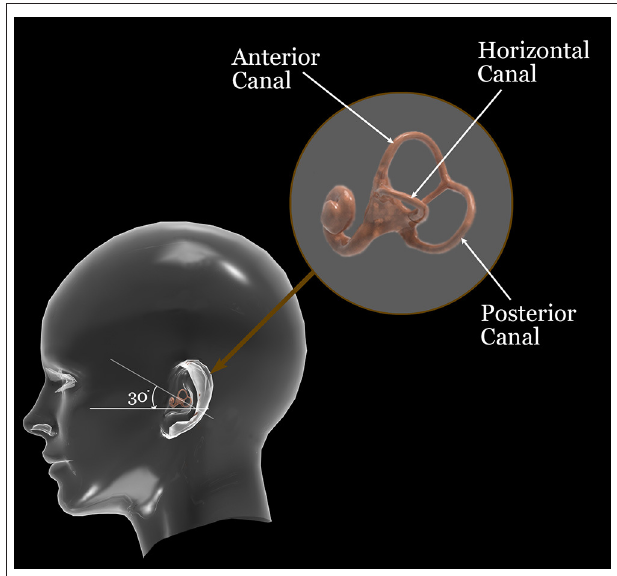
FIGURE 1 | Orientation of the three semicircular